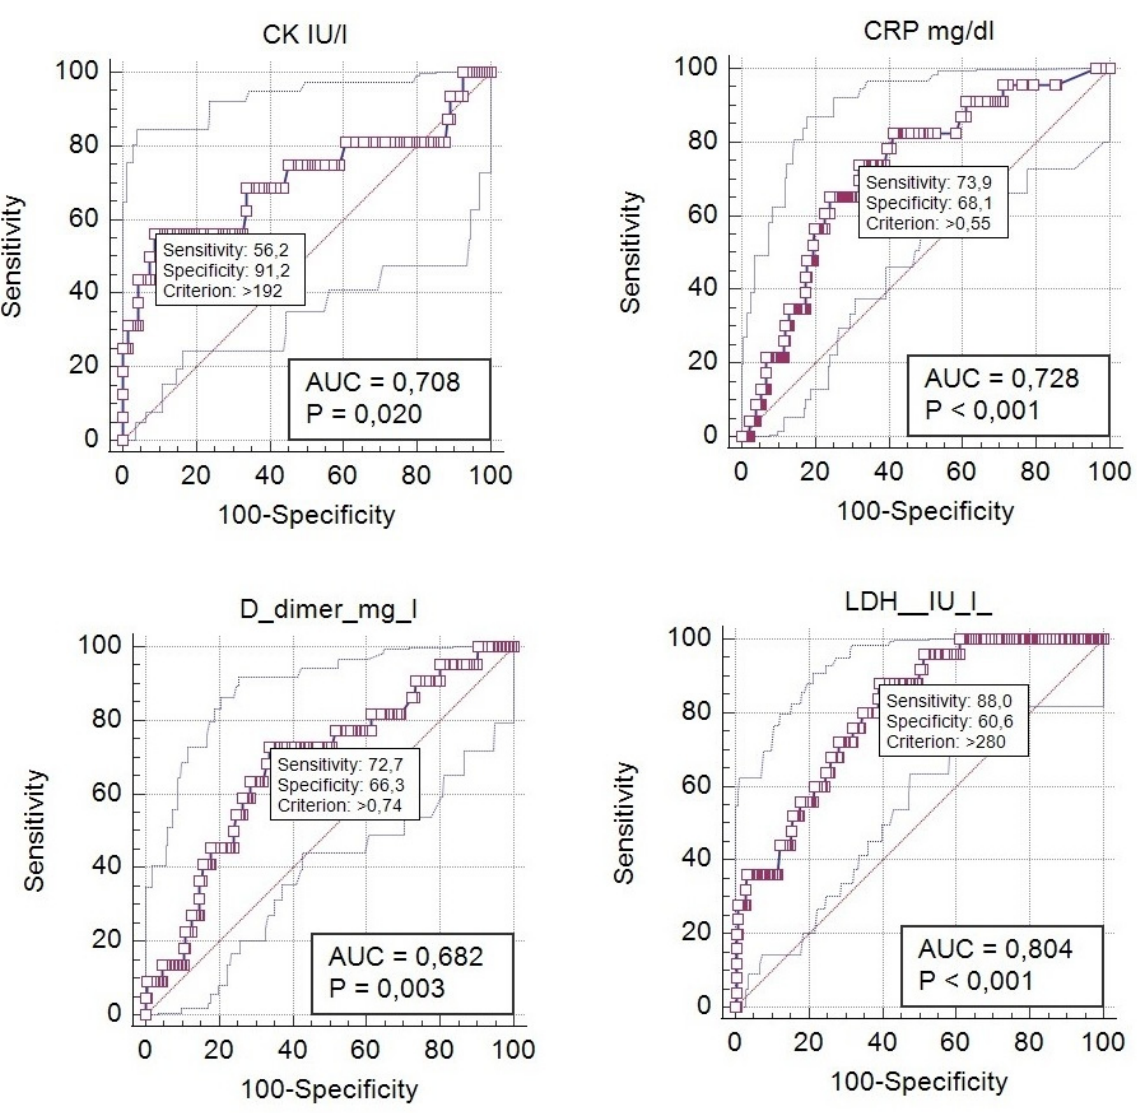
Figure 2. ROC curve analysis for the selected biochemical parameters and the need for oxygen therapy; AUC—area under the curve.